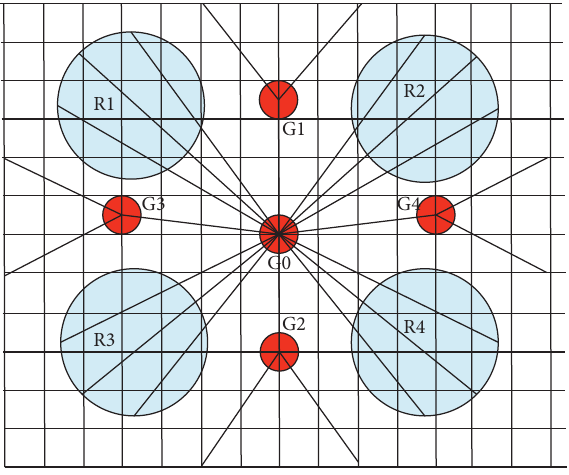
Figure 4: Route radiation